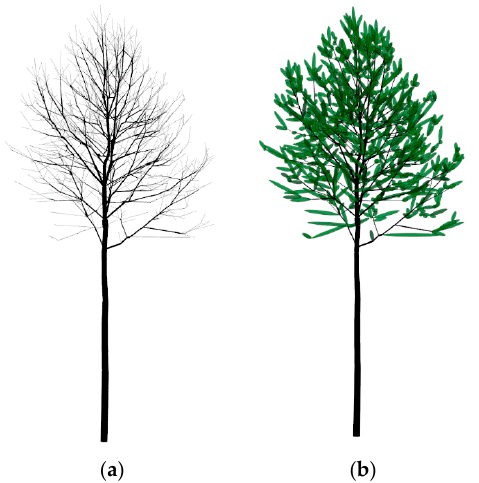
Figure 2. The 3D tree model ( a ) in the “leaf-off” mode; ( b ) in the leafy-ellipsoidal “leaf-on” mode (here shown with 5 cm width of the minor axis of the ellipsoid).